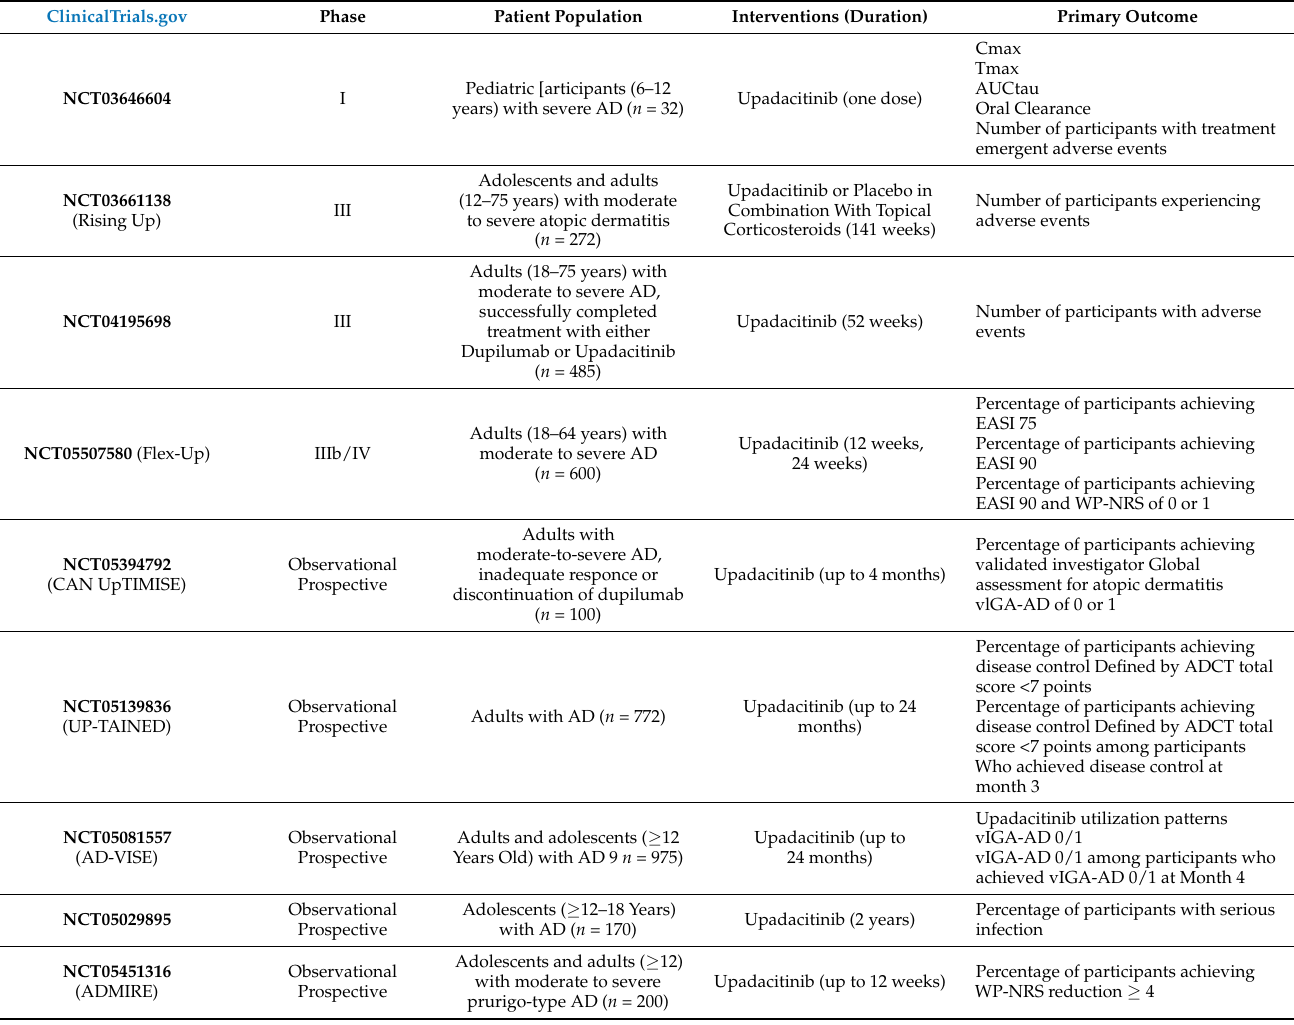
Table 3. Ongoing clinical trials of upadacitinib treatment in patients with moderate-to-severe atopic